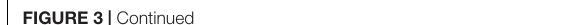
FIGURE 3 | Continued each cross, Cross I: RIL4078 × KNG, Cross II: RIL4013 × RIL4078, Cross III: RIL4058 × RIL4013. Blue and orange bars show mean germination percentages for F 2 plants with homozygous H602 or KNG genotypes at the DNA markers, respectively. Vertical bars: standard deviation. n = 3 spikes. Italic letters: DNA marker names. Data were analyzed using a Student’s t -test. Two asterisks: significant difference at p < 0.01. Three asterisks: significant difference at p < 0.001. n.s., no significant